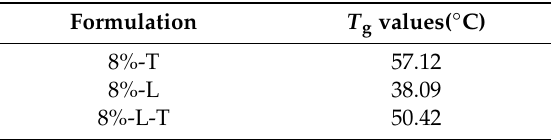
Table 5. T g values of lyophilized samples.